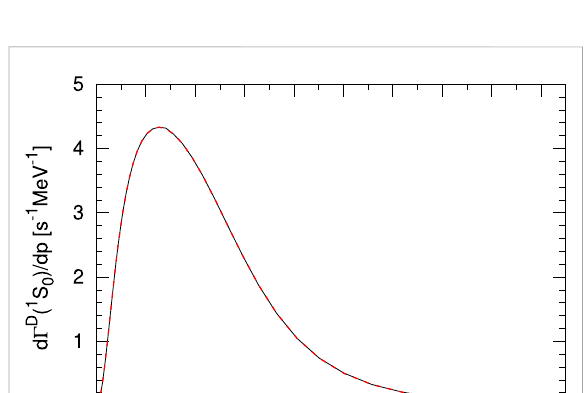
FIGURE 2 Differential doublet capture rate in the 1 S 0 nn channel, ) / dp in s − 1 MeV − 1 , as a function of the nn relative d Γ D ( 1 S 0 momentum p in MeV, calculated using either the Numerov (black solidline)orthevariational(reddashedline)methodsinorder to obtain the deuteron and the nn scattering wave functions. The curves are exactly on top of each other. The NVIa potential and consistent currents at N3LO are used. The axial charge radius is taken to be r 2 A (cid:2) 0 . 46 fm 2 .